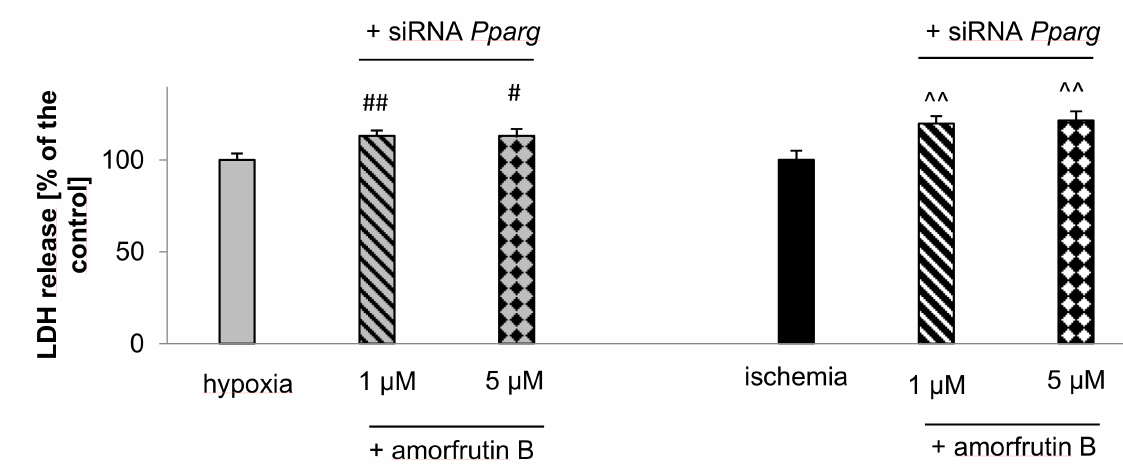
Figure 5. In Pparg siRNA-transfected cells, amorfrutin B (1 or 5 µ M) lost the neuroprotective potential that was manifested by increased LDH release levels in both hypoxic and ischemic models. Neuronal cell cultures were transfected with 50 nM Pparg siRNA in INTERFERin-containing medium without antibiotics for 7 h. Then, the cells were exposed to hypoxia or ischemia for 6 h and next treated with amorfrutin B during the reoxygenation. The results were normalized to the absorbance in negative control siRNAs. The results are presented as a percentage of the control ± SEM of 3 independent experiments, consisting of 5–8 replicates per group. # p < 0.05 and ## p < 0.01 compared to the cultures exposed to hypoxia, ˆˆ p < 0.01 compared to the cultures exposed to ischemia.